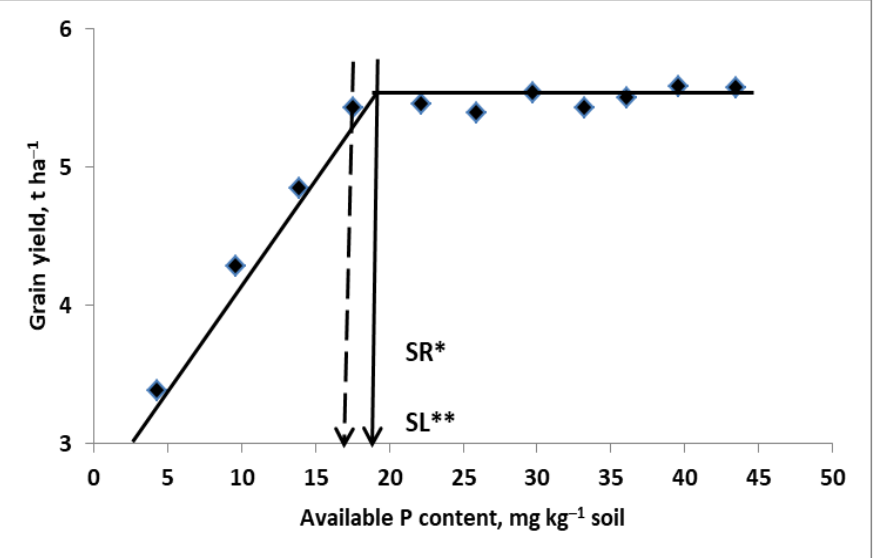
Figure 8. Yield of wheat response to the content of available phosphorus (based on [134]). Legend: * SR, ** SL, phosphorus sufficiency range, sufficiency level of the content of available P (determined by Olsen method).